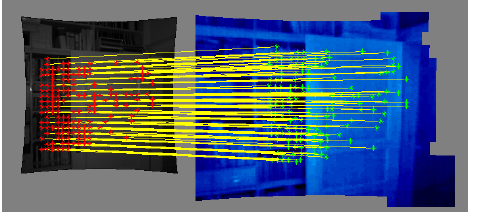
Figure 12: Visualization of the reliability of the range measure- ments: Reliable measurements are represented in red and the re- liability decreases via yellow, green and blue to violet.